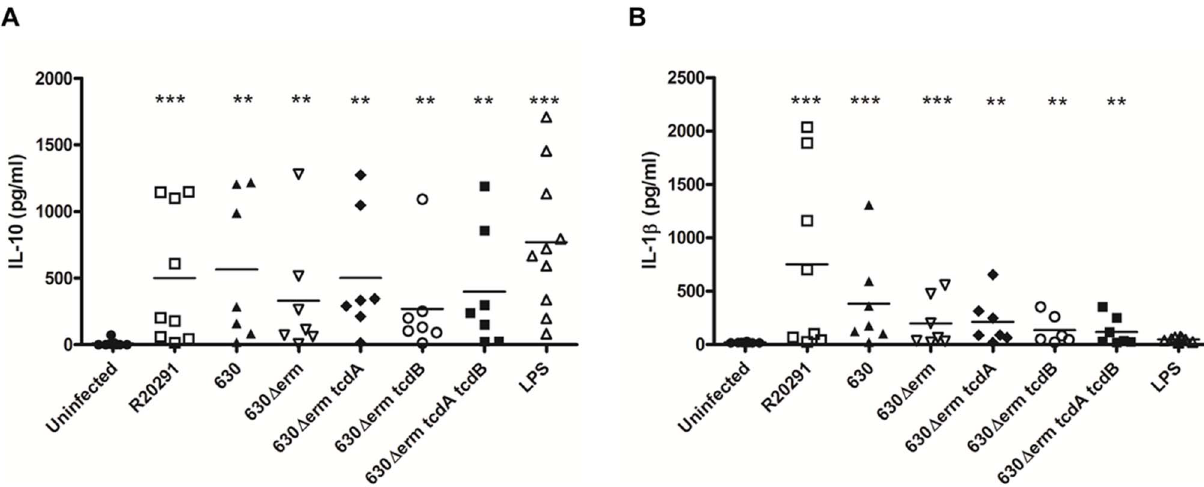
Figure 5. C.difficile- mediated effects on human monocyte-derived DC IL-10 and IL-1 b production. Human mDCs from nine healthy donors were stimulated with C. difficile at an MOI of 10. IL-10 (A) and IL-1 b (B) secretion measured 8h post-infection. **p , 0.01 and ***p , 0.001 represent significant difference from uninfected control cells. Data was analysed using Mann-Whitney U test.